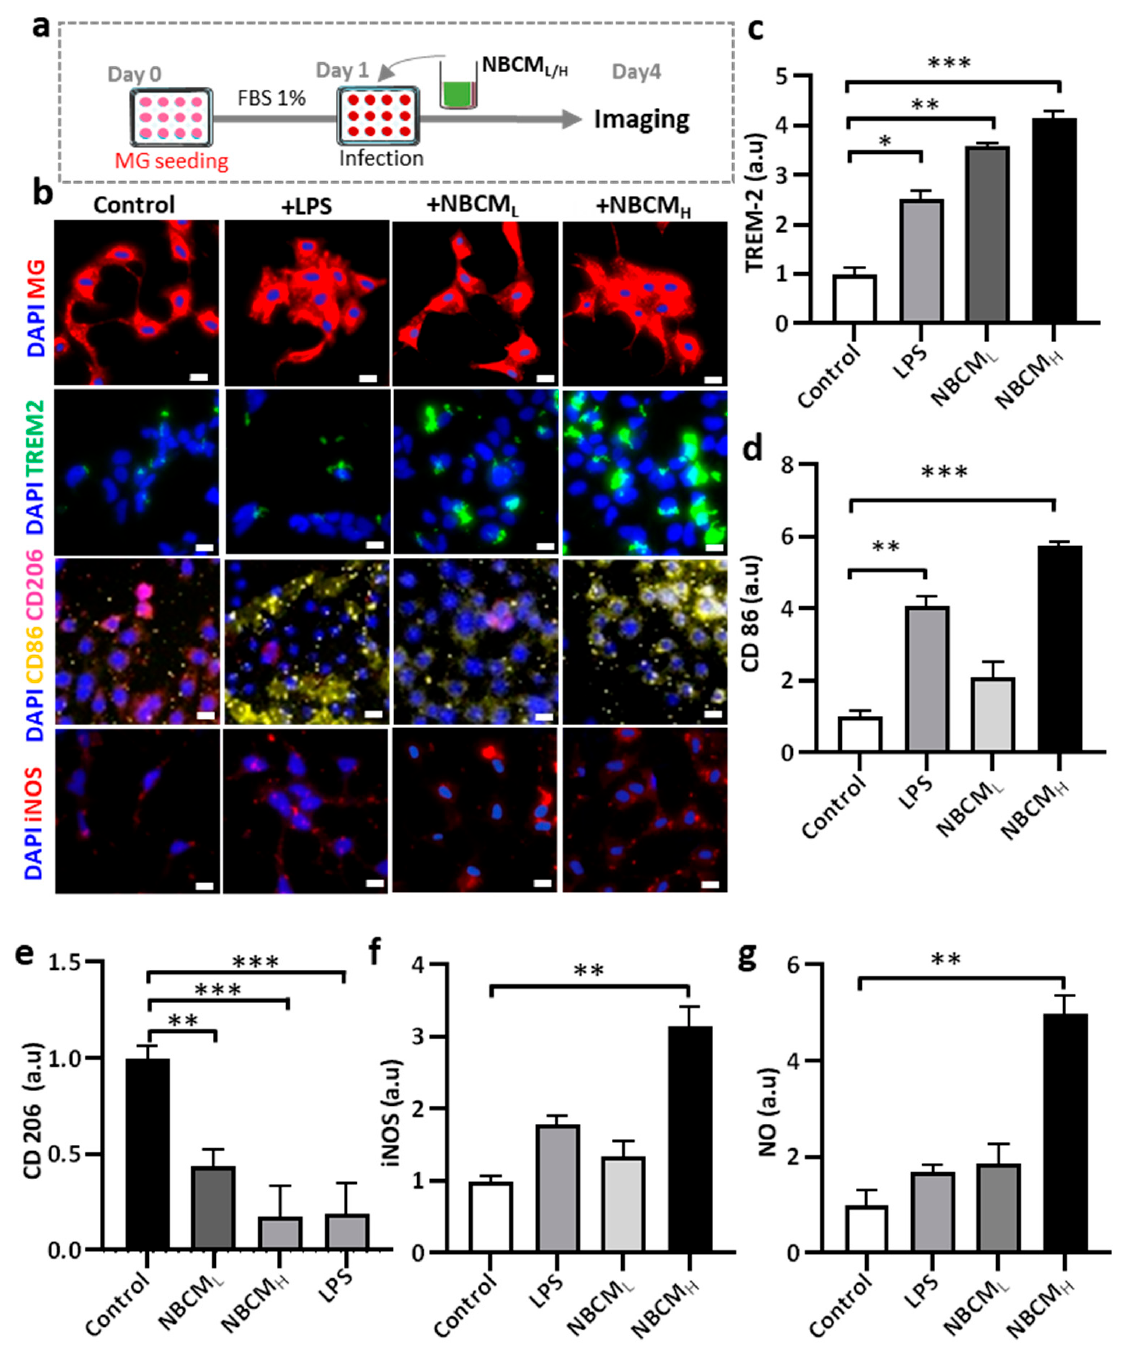
Figure 4. Neuron-glia interaction assessed by BCM L/H - and MBCM L/H -stimulated neurons/astrocytes conditioned media. ( a ) Schematic diagram showing experimental timeline for investigating astrogliosis and microgliosis. ( b ) Morphological changes, immunostaining of SV40 microglia cell treated with 10 ng/mL LPS, [1 NBCM:10 MM] and [1 NMBCM:10 MM] against TREM-2, CD86, CD206 and iNOS in a single culture system. ( c – f ) Quantification of TREM-2, CD86, CD206 and iNOS in stimulated microglia. ( g ) Analysis of nitric oxide released by stimulated microglia. All experiments were repeated three times independently and statistically analyzed by One-way ANOVA followed by Tukey HSD test (* p < 0.05, ** p < 0.01 and *** p < 0.001). All data were presented as mean ± standard deviation (SD).